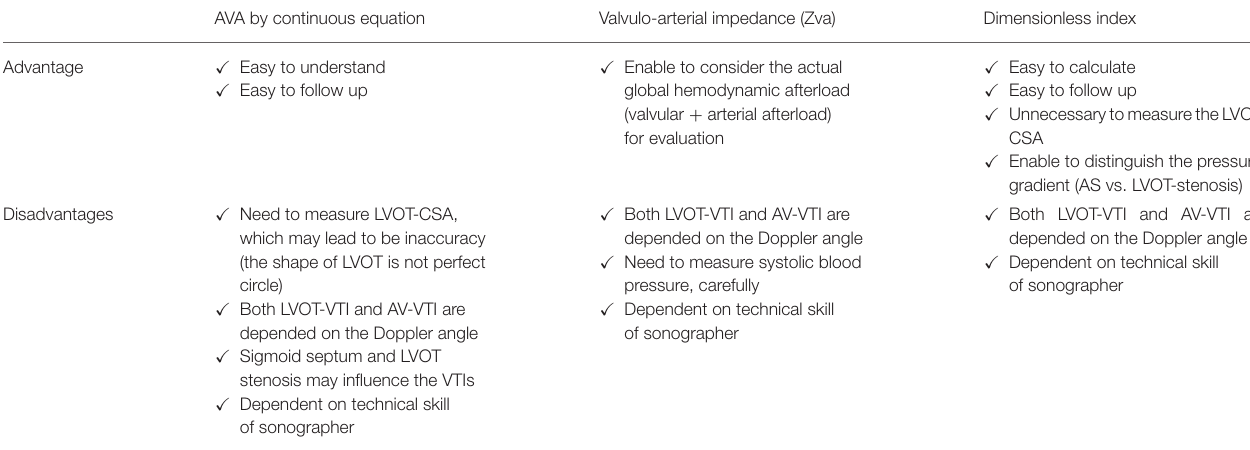
TABLE 2 | Comparison of AS parameters. AVA by continuous equation